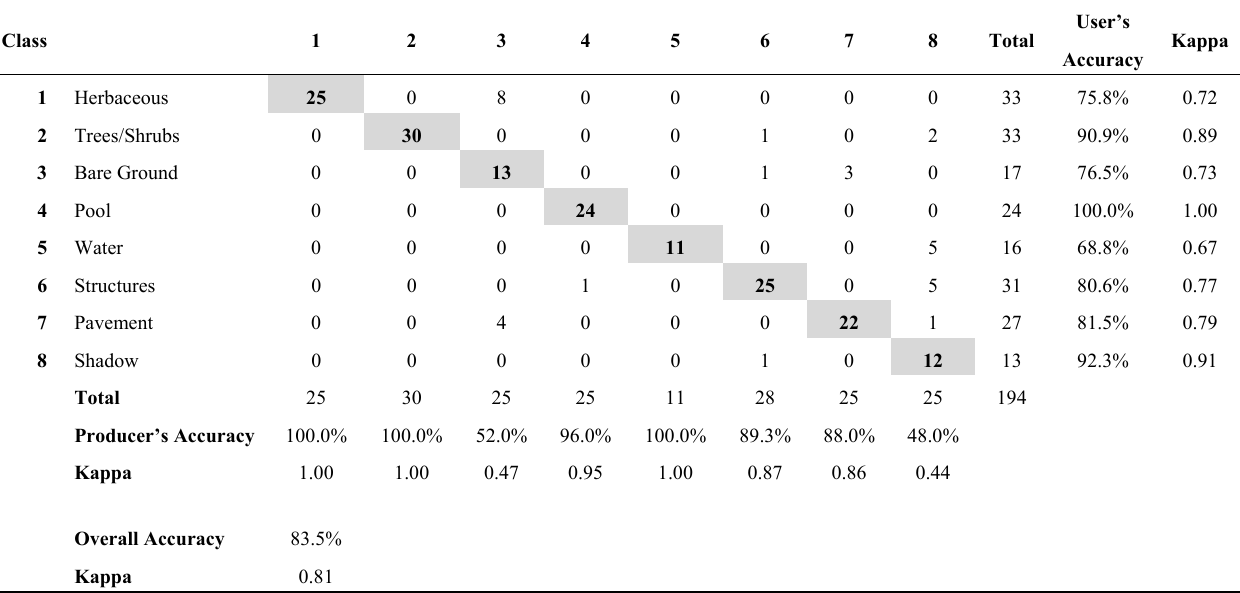
Table 4. Error matrix results for the classification performed with 2007 NAIP data, NDVI data, 2008 LiDAR CHM, and 2008 intensity LiDAR data. Data includes 4 bands